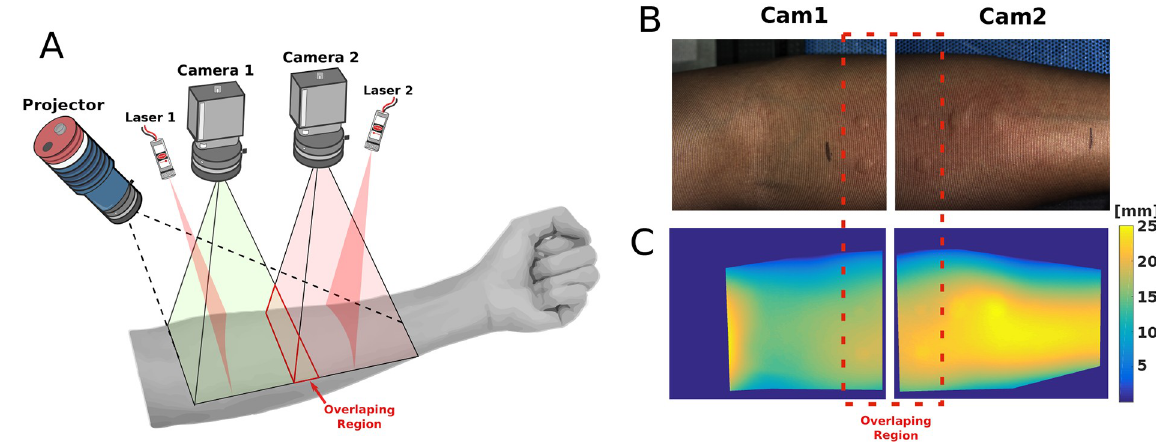
Fig 2. (A) 3D imaging system. (B) Captured fringe images. (C) 3D Reconstructions. The dotted red line denotes the overlapping region between the observation systems.